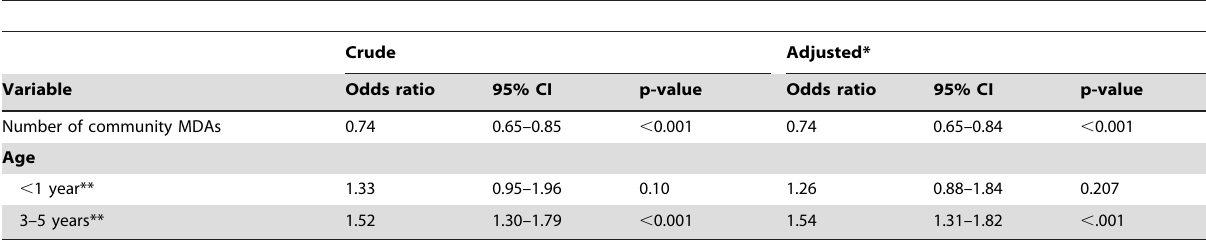
Table 4. Odds ratios for factors associated with C. trachomatis infection in children with clinical signs of